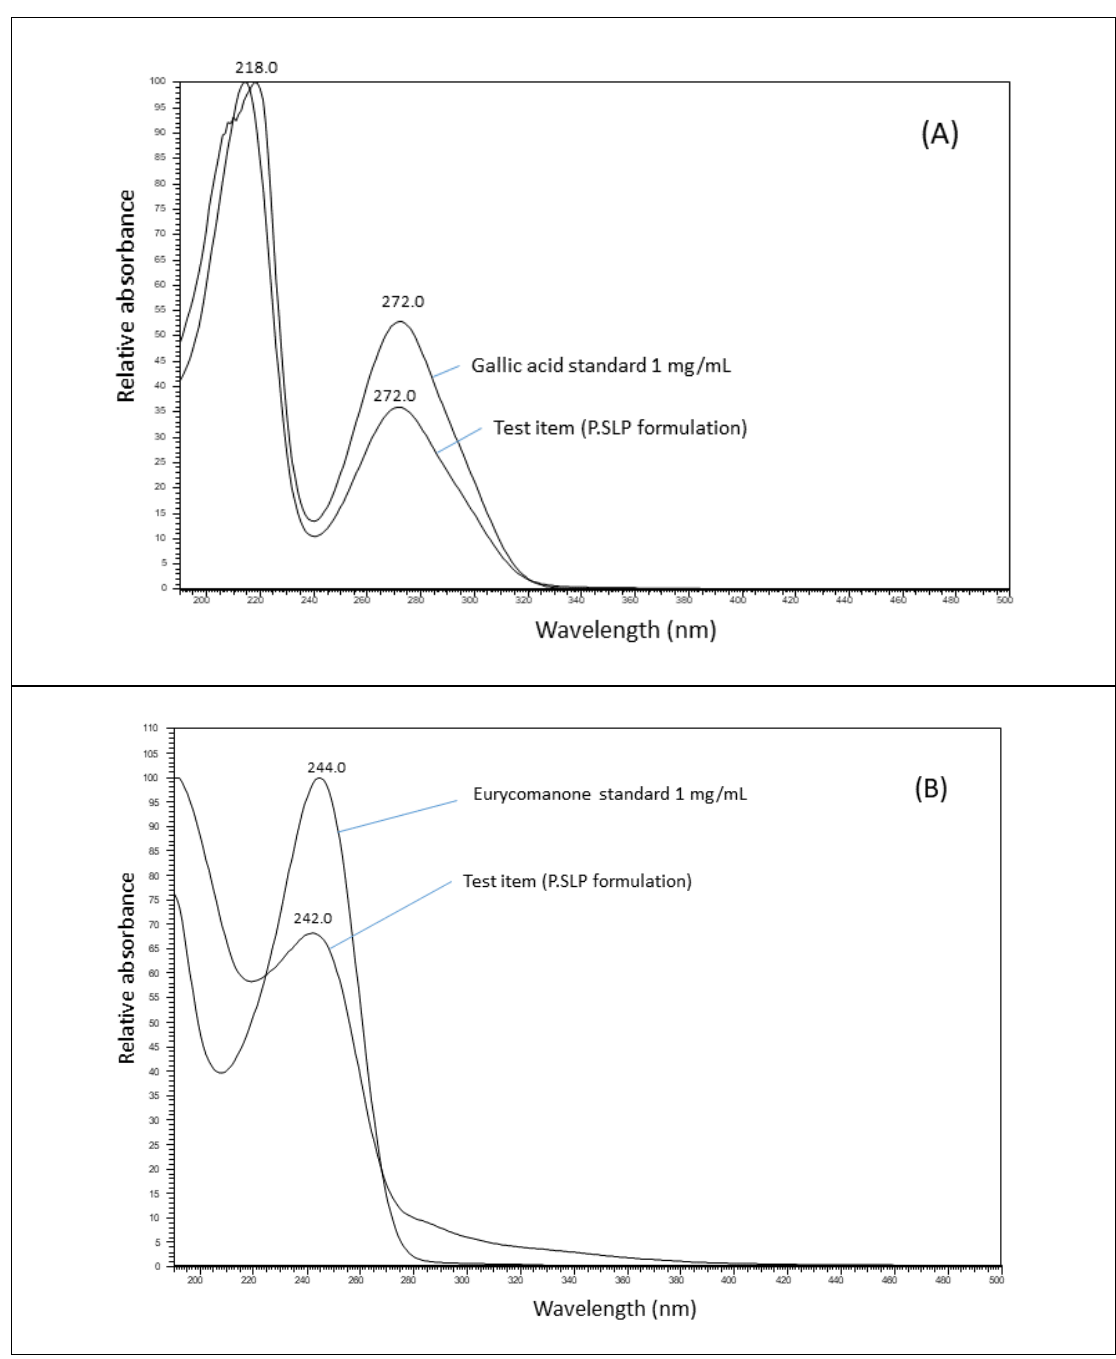
Figure 2. The LC-MS profile of the P.SLP formulation and the extracted ion mass of chemical markers gallic acid (retention time (t R ) = 2.1 min, mass-to-charge ratio ( m / z ) = 169) and eurycoma- none (t R = 5.80 min, m / z = 407).